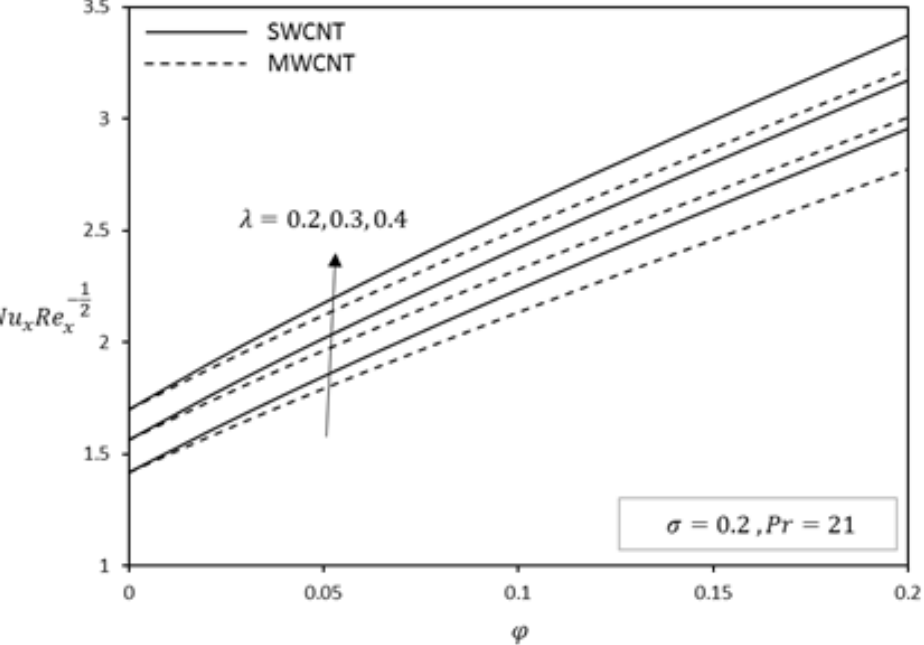
Figure 16. Effect of λ on Nusselt number for kerosene-based fluid.